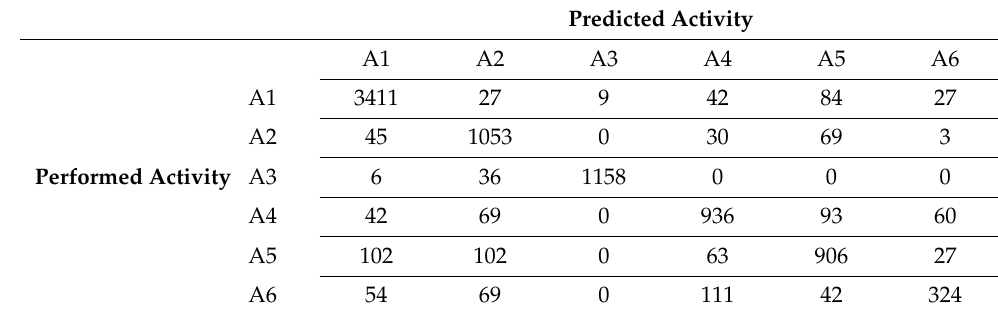
Table 8. The confusion matrix obtained for the second evaluation scenario.